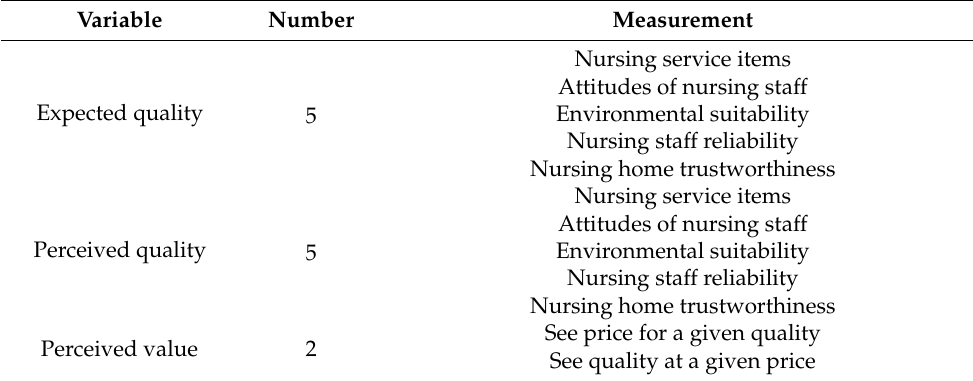
Table 1. Nursing service elderly satisfaction index